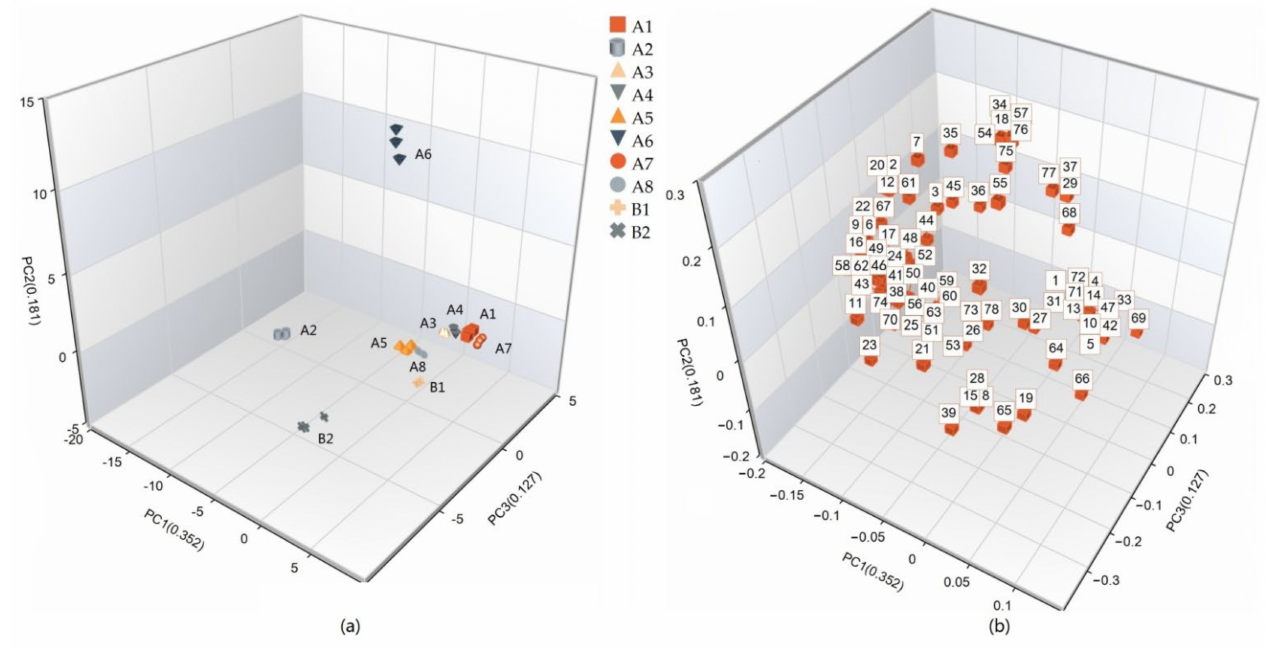
Figure 1. ( a ) Separation of the 10 groups in PCA space based on the OAV of volatile compounds; ( b ) Distribution of 78 volatile compounds in the 10 groups (numbers correspond to those in Table